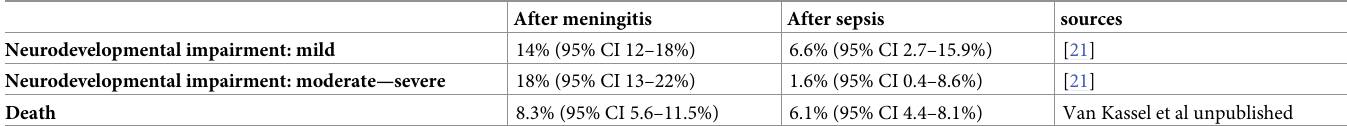
Table 2. Transition